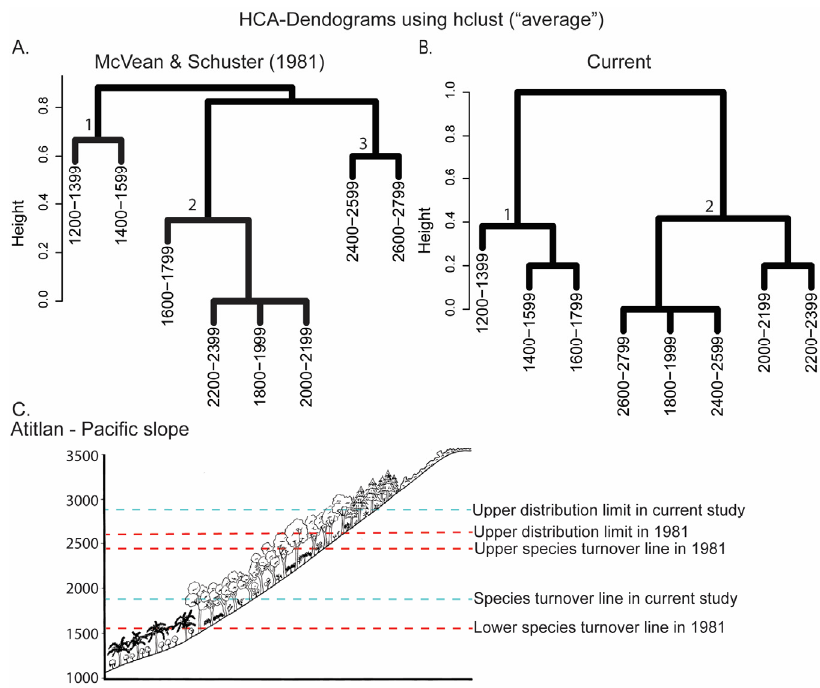
Figure 2. ( A ) Dendrogram of the HCA for the presence–absence of passalid beetle species in 200 m altitudinal belts (m a.s.l.) for the Atitlan volcano in 1981. ( B ) Dendrogram of the HCA for the presence–absence of passalid beetle species in 200 m altitudinal belts (m a.s.l.) for the Atitlan volcano in the current study. ( C ) Pacific slope of the Atitlan volcano, modified from McVean and Schuster (1981), showing the species turnover line and upper distribution limit of Passalidae for each sampling period. Table 2. Species composition of the HCA clusters for each volcano and sampling period.